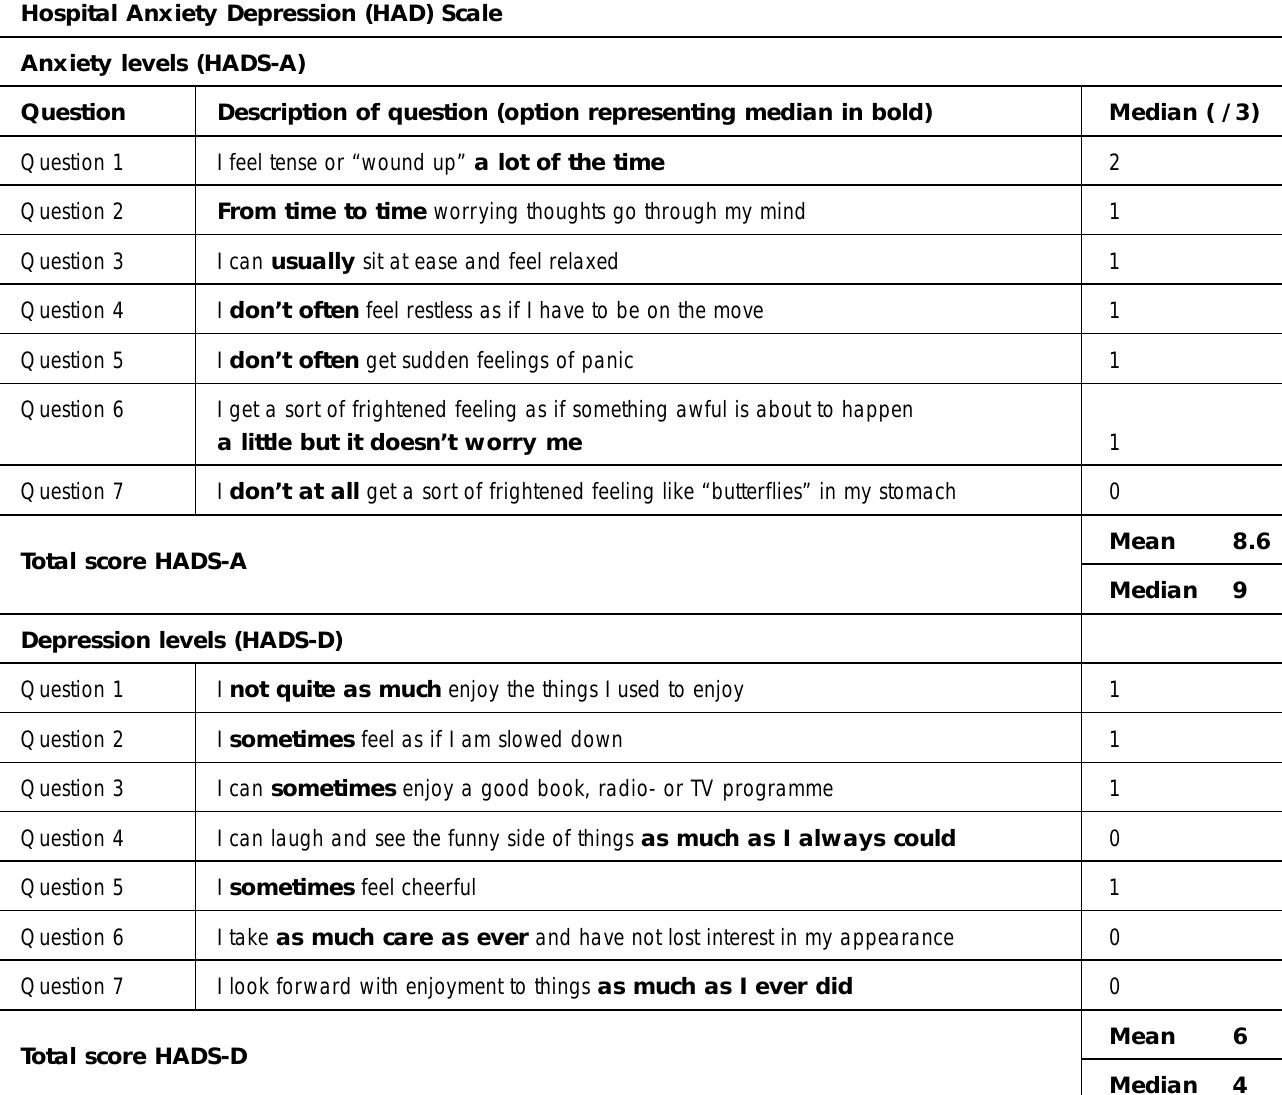
Table 3: Descriptions of the option representing the calculated median for each question of the HAD Scale by the 21 subjects and the total score. Hospital Anxiety Depression (HAD) Scale Anxiety levels